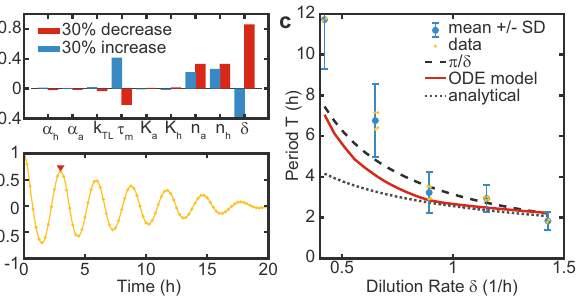
Fig. 3 The period of the free oscillator is determined by the dilution rate.